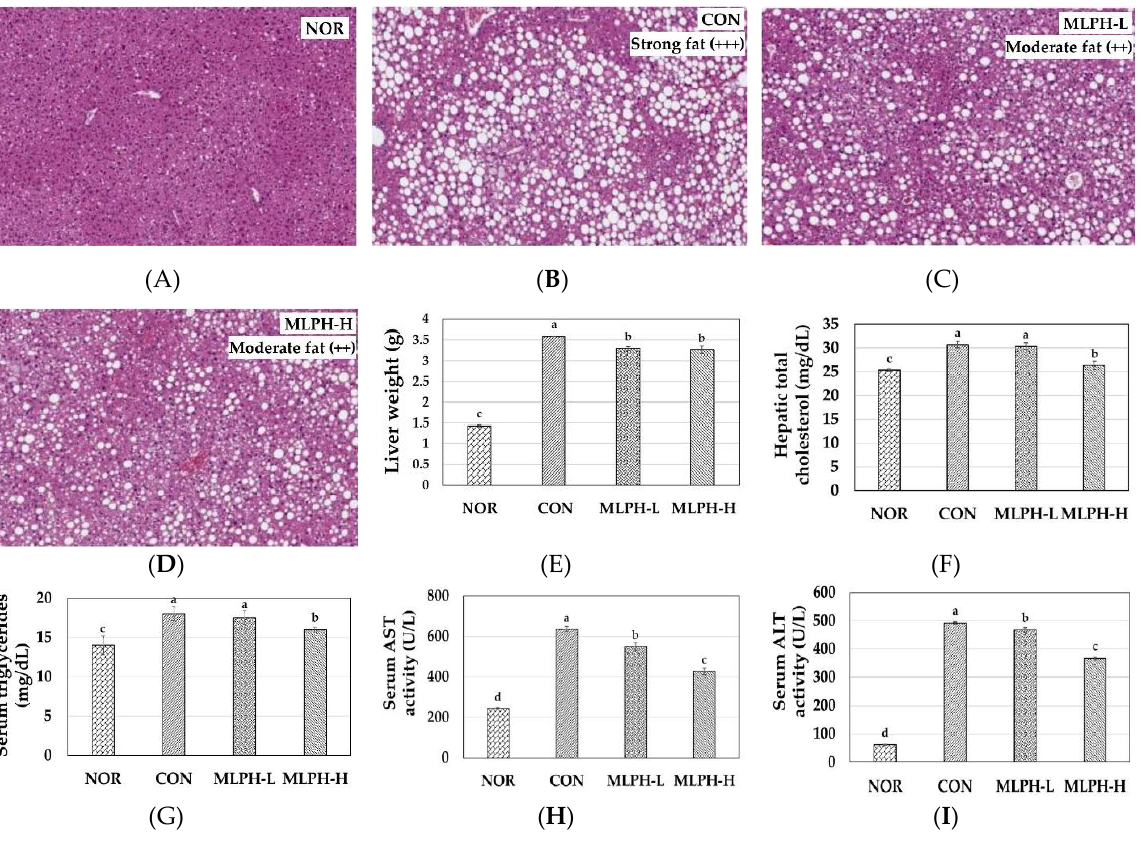
Figure 4. Effect of MLPH fraction on histology of mouse liver in ( A ) NOR, ( B ) CON, ( C ) MLPH-L, and ( D ) MLPH-H groups; ( E ) liver weight; ( F ) hepatic total cholesterol, including hepatic marker enzymes; ( G ) serum triglycerides; ( H ) serum AST; and ( I ) serum ALT. Each value represents the mean ± SEM ( n = 6). a-c Values not sharing a common letter are significantly different at p < 0.05 by Tukey’s multiple comparison test.